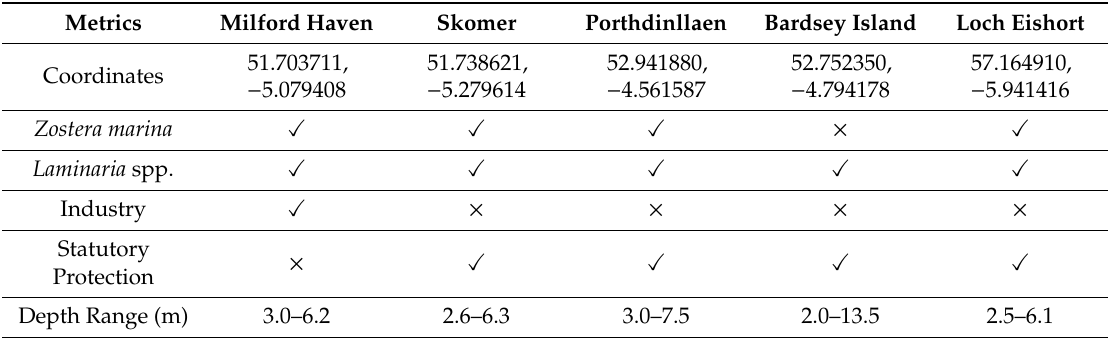
Figure 1. Locations of the baited remote underwater video (BRUV) deployments in seagrass and kelp. Study sites are Loch Eishort, Porthdinllaen, Bardsey Island, Milford Haven, and Skomer Island. Table 1. Overview of the seagrass and kelp fish assemblage study site characteristics on the west coast of the UK.